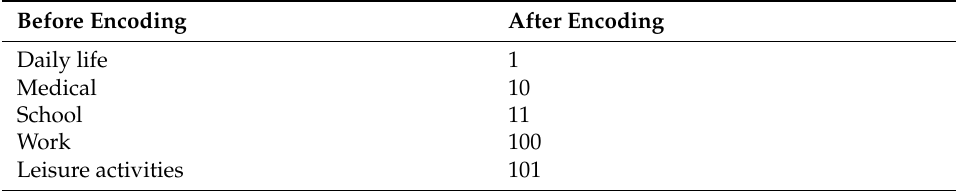
Table 1. Examples of use purposes and activity requirements. Before Encoding After